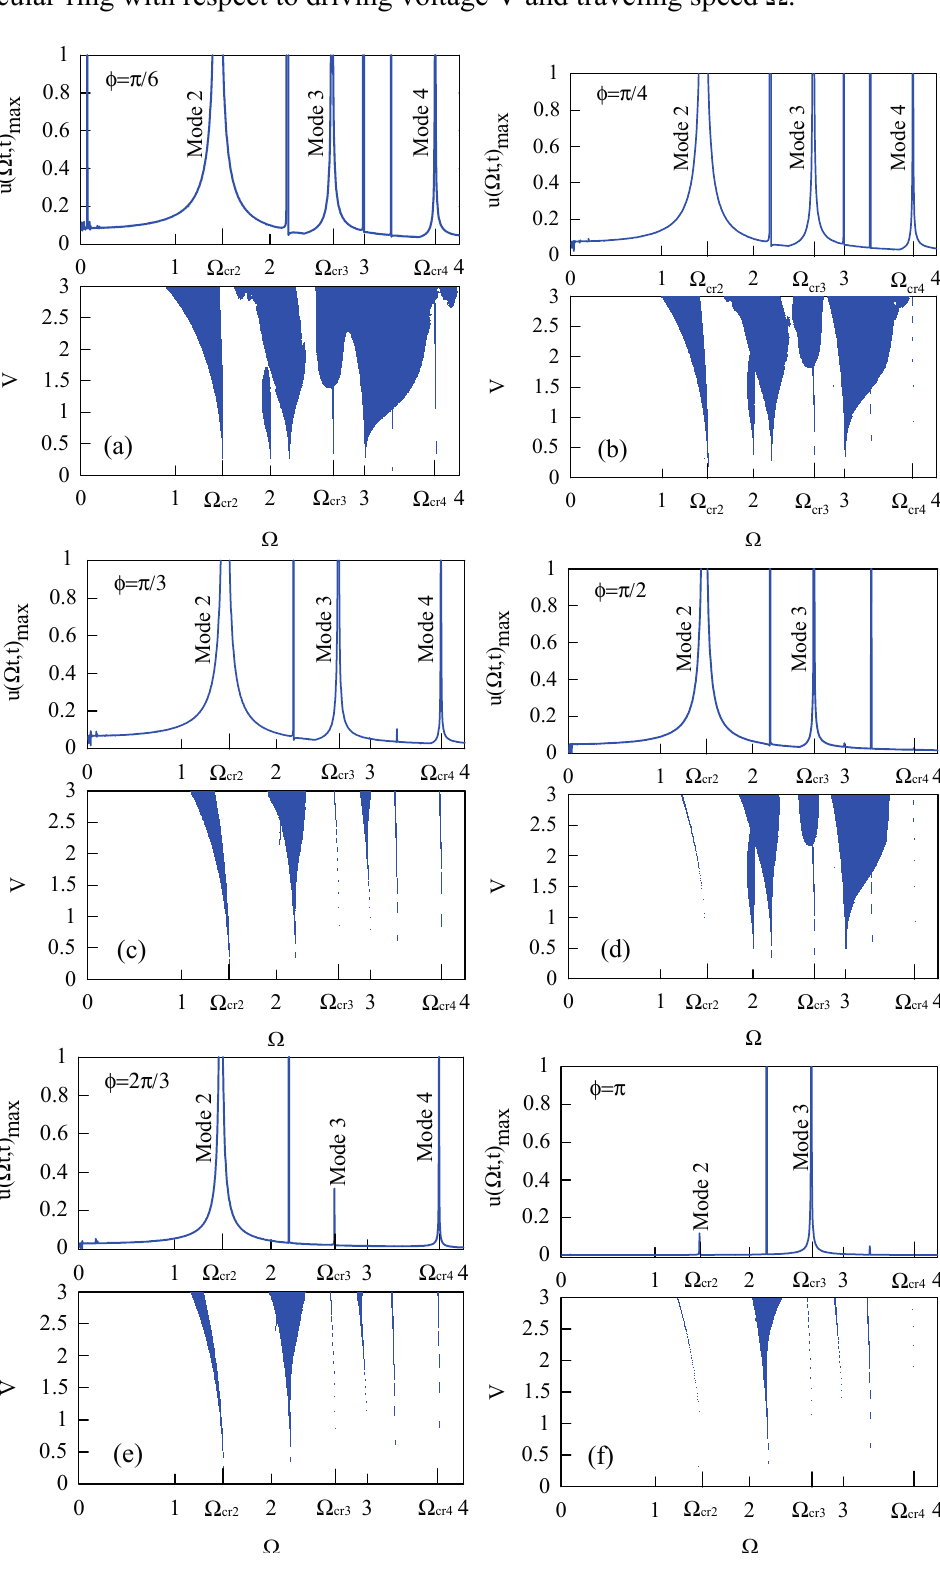
Figure 8. The stabilities of the circular-ring with respect to driving voltage V and traveling speed Ω for different electrode span angle ϕ . The upper parts of Figure ( a )–( f ) is the maximum responses of the circular ring at the central point of the distributed traveling electrostatic force ( V = 1), while the lower part of each figure shows the instable region of the circular-ring with respect to driving voltage V and traveling speed Ω